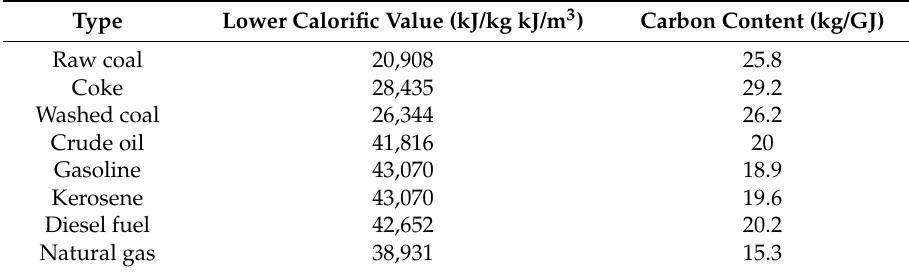
Table 3. Net heating values and carbon contents of combusted fossil